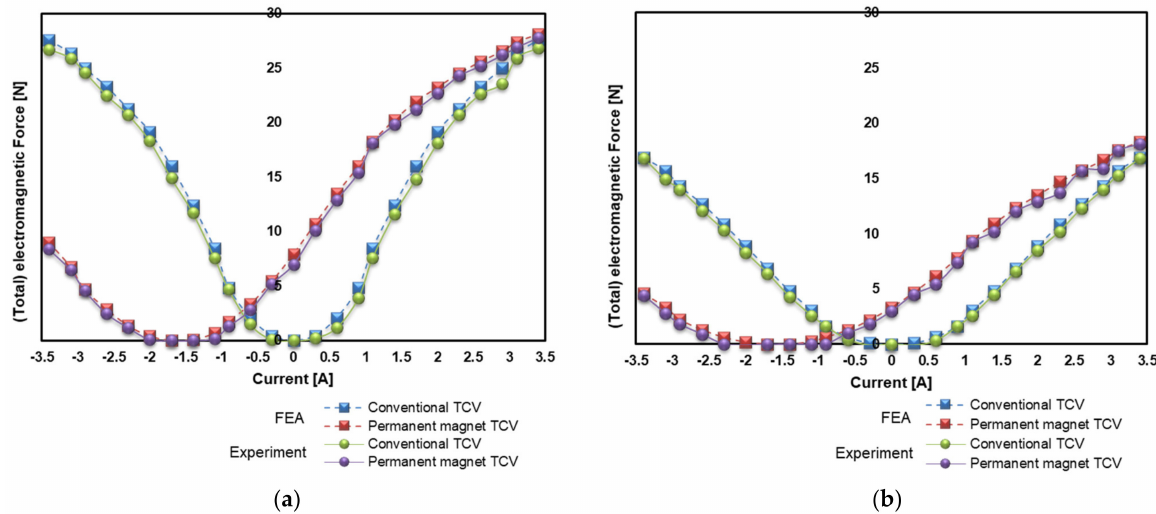
Figure 19. Comparison of FEA and experiment results: ( a ) 0 mm stroke; ( b ) 0.3 mm